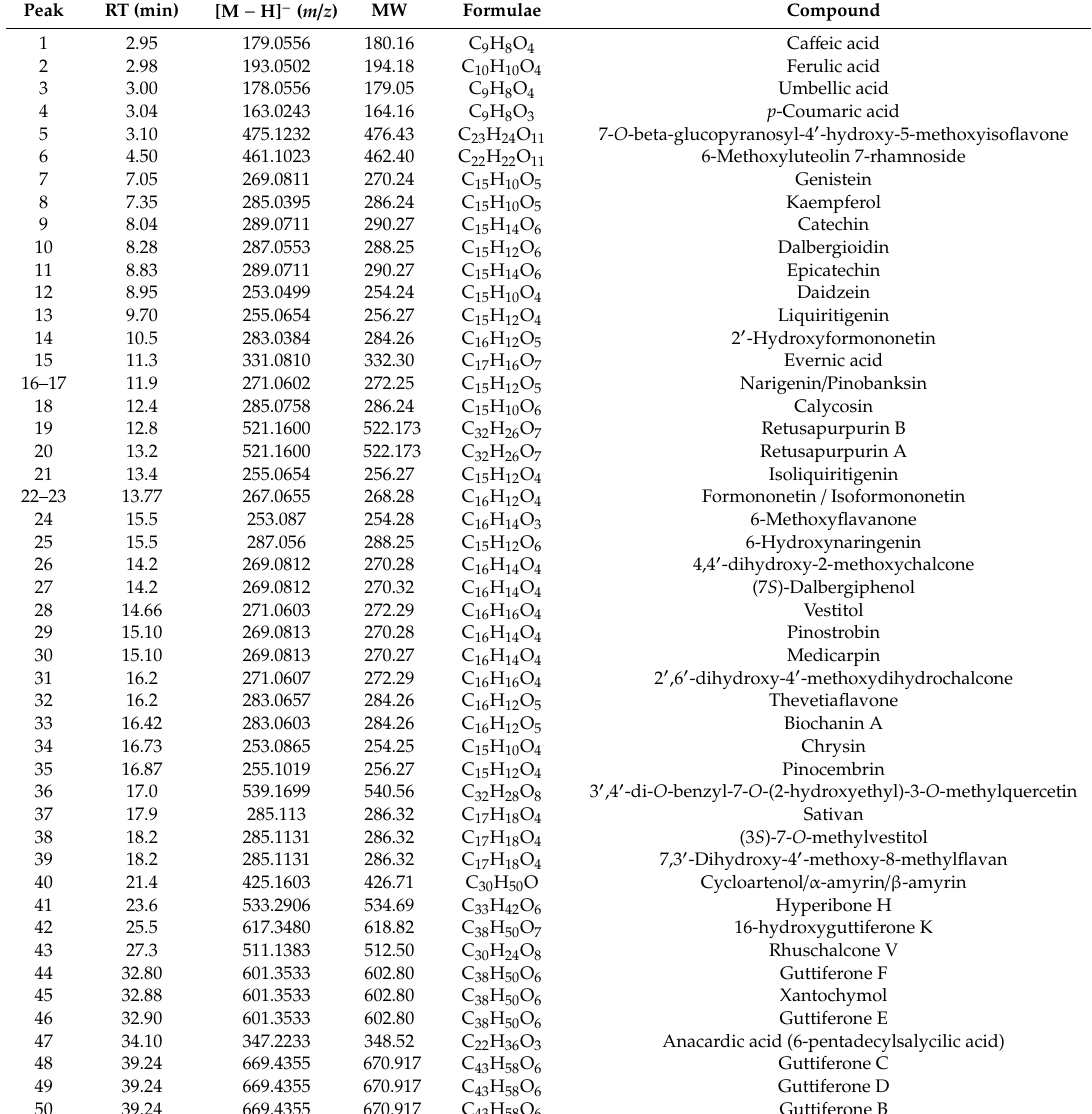
Table1. Identificationandconfirmationofsomemarkersoftheredpropolisextract(RPE)usingOrbitrap- coupled liquid chromatography and Fourier transform mass spectrometry (LC-Orbitrap-FTMS).